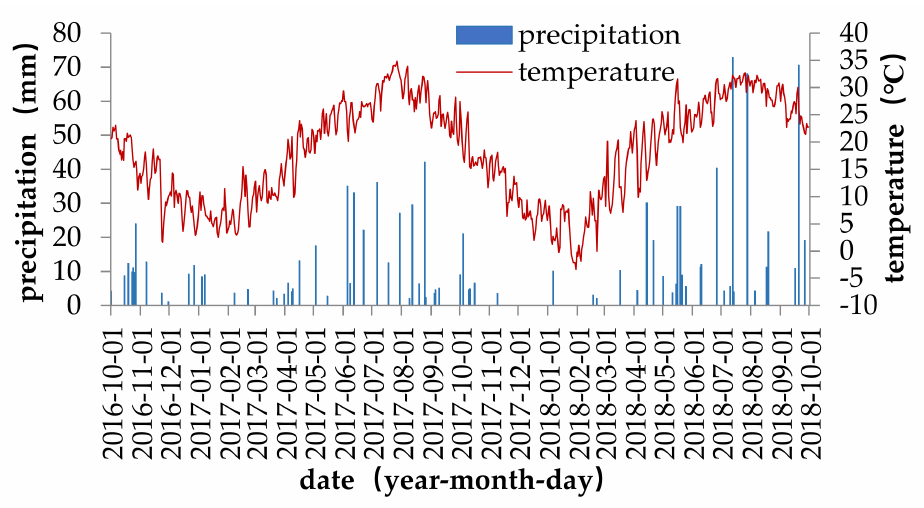
Figure 1. Distribution of precipitation and temperature during winter wheat growth period in 2016 − 2018. Table 1. Soil physical and chemical